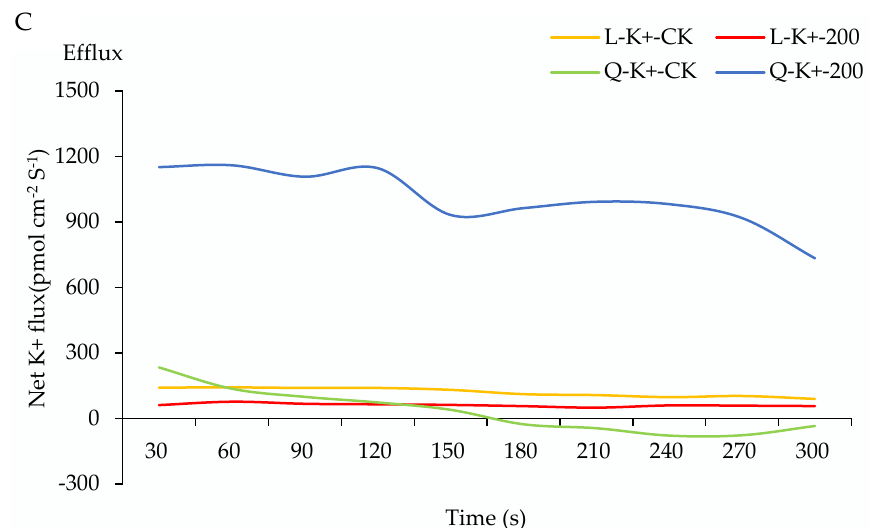
Figure 4. Ion flux analysis of root meristem of two potato cultivars. The net ion flux (the flux offset by the efflux and influx) was obtained. ( A – C ) represented the net flux of Ca 2+ , Na + , and K + , respectively. L-Ca 2+ -CK: The net Ca 2+ ion flux was observed in ‘Longshu 5’, which was grown in Murashige and Skoog (MS) medium without NaCl stress; L-Ca 2+ -200: The net Ca 2+ ion flux was observed in ‘Longshu 5′, which was grown in MS medium with 200 mmol/L NaCl stress; Q-Ca 2+ -CK: The net Ca 2+ ion flux was observed in ‘Qingshu 9′, which was grown in MS medium without NaCl stress; Q-Ca 2+ -200: The net Ca 2+ ion flux was observed in ‘Qingshu 9’, which was grown in MS medium with 200 mmol/L NaCl stress; L-Na + -CK: The net Na + ion flux was observed in ‘Longshu 5’, which was grown in MS medium without NaCl stress; L-Na + -200: The net Na + ion flux was observed in ‘Longshu 5′, which was grown in MS medium with 200 mmol/L NaCl stress; Q-Na + -CK: The net Na + ion flux was observed in ‘Qingshu 9’, which was grown in MS medium without NaCl stress; Q-Na + -200: The net Na + ion flux was observed in ‘Qingshu 9’, which was grown in MS medium with 200 mmol/L NaCl stress; L-K + -CK: The net K + ion flux was observed in ‘Longshu 5’, which was grown in MS medium without NaCl stress; L-K + -200: The net K + ion flux was observed in ‘Longshu 5’, which was grown in MS medium with 200 mmol/L NaCl stress; Q-K + -CK: The net K + ion flux was observed in ‘Qingshu 9’, which was grown in MS medium without NaCl stress; Q-K + -200: The net K + ion flux was observed in ‘Qingshu 9’, which was grown in MS medium with 200 mmol/L NaCl stress. Data shows ion flow within 300 s. The positive value represented a net ionic efflux; The positive value represented a net ionic influx.